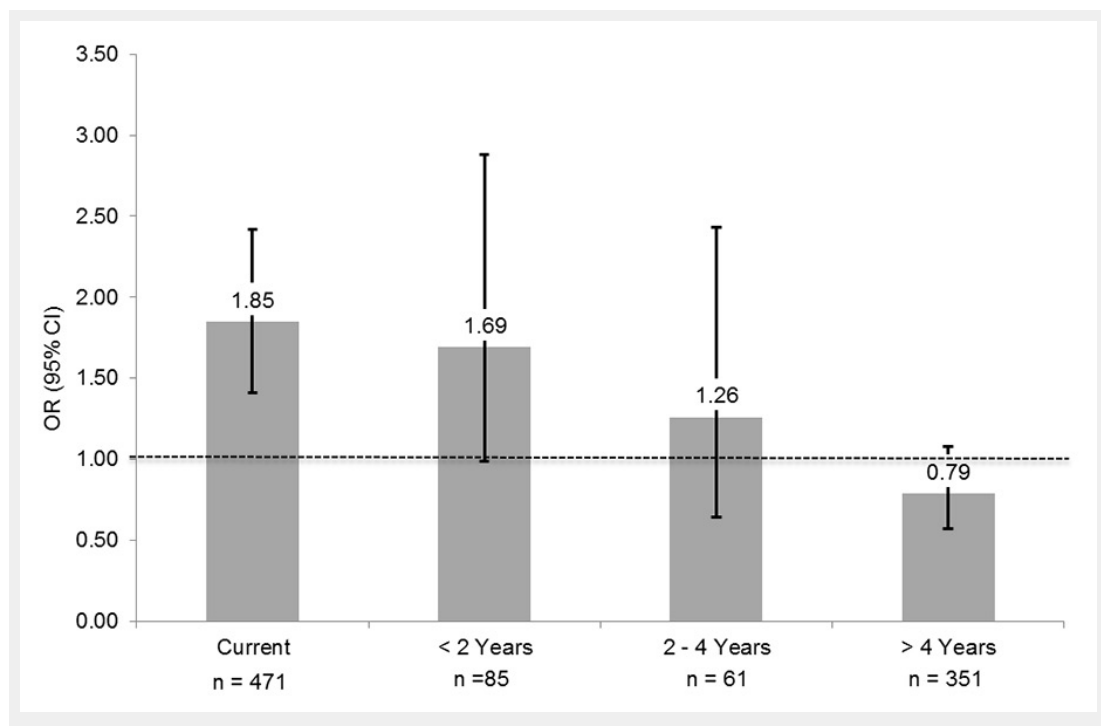
Figure 3 Relationship of pre-diabetes with time since smoking cessation. Never smokers represent the reference group. Boxes indicate odds ratios, whiskers are 95% confidence intervals. Data are adjusted for age, sex, Body Mass Index, hypertension, alcohol consumption, education, low density lipoprotein and high density lipoprotein cholesterol, physical activity, fruit/vegetable consumption and body